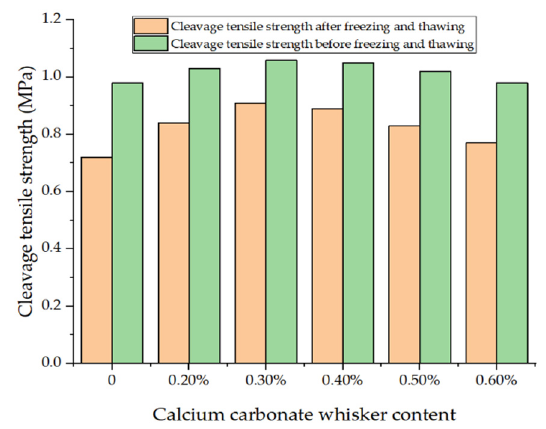
Figure 8. Freeze-thaw splitting test results of calcium carbonate whisker asphalt mixture.